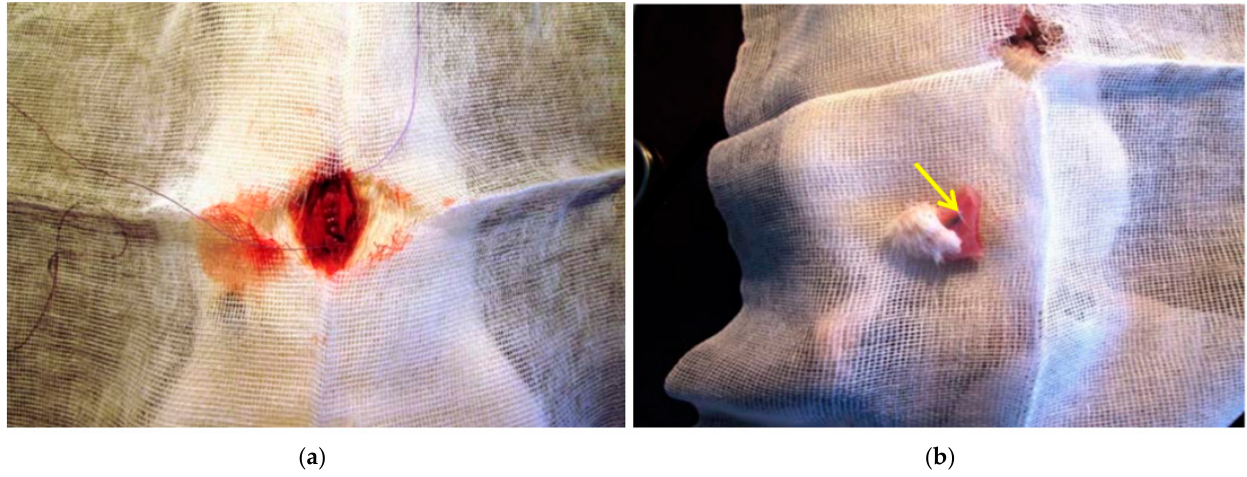
Figure 4. Surgical implantation of CoCr tubes PLA@Fe@C NPs into the subcutaneous tissue of a Figure 1. Surgical implantation of CoCr tubes @ PLA @ Fe@C NPs into the subcutaneous tissue of 157 laboratory animal ( a ); operation of excision of subcutaneous tissue and muscles with a sample metal laboratory animal (on the left); operation of excision of subcutaneous tissue and muscles with a tube (yellow arrow) coated with a nanocomposite ( b sample metal tube (yellow arrow) coated with a nanocomposite (on the right).